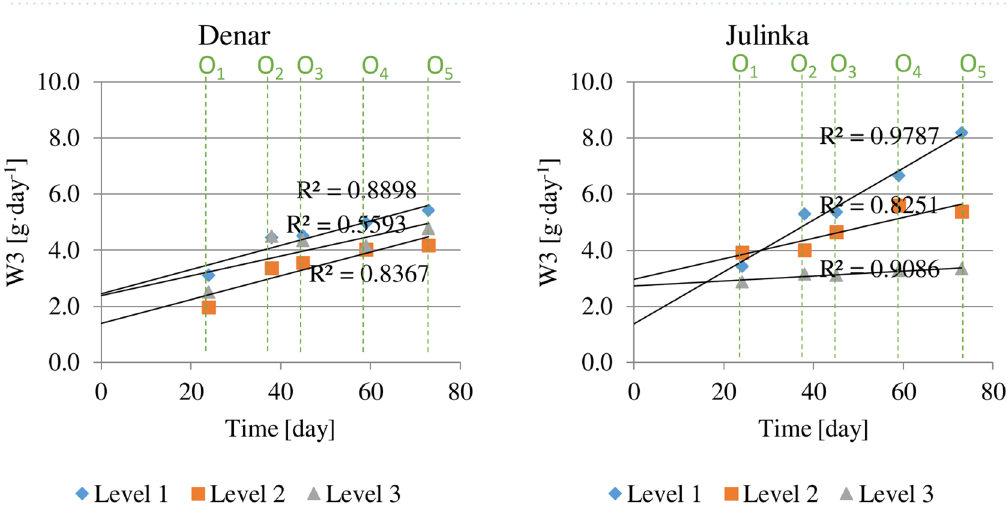
Figure 7. Average daily potato varieties tuber increase, at three soil humidity levels (1, 2, 3), cumulative calculation from potato